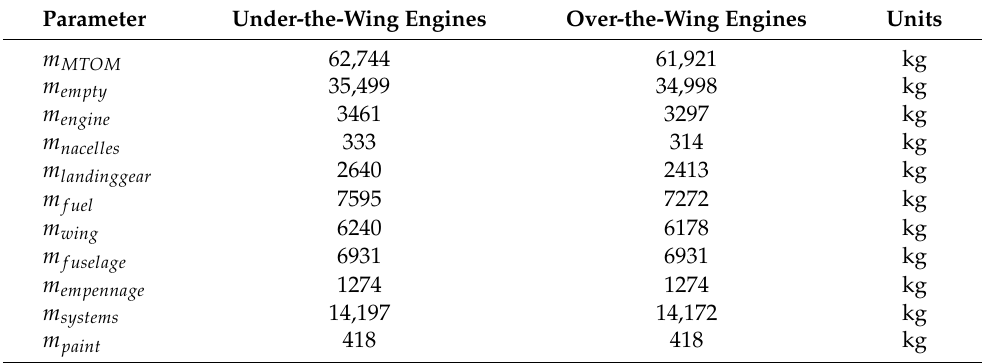
Table 5. Comparison between two forward-swept wing configurations with under and over-the-wing engines. Fuel mass is specified for the maximum payload scenario. Parameter Under-the-Wing Engines Over-the-Wing Engines Units